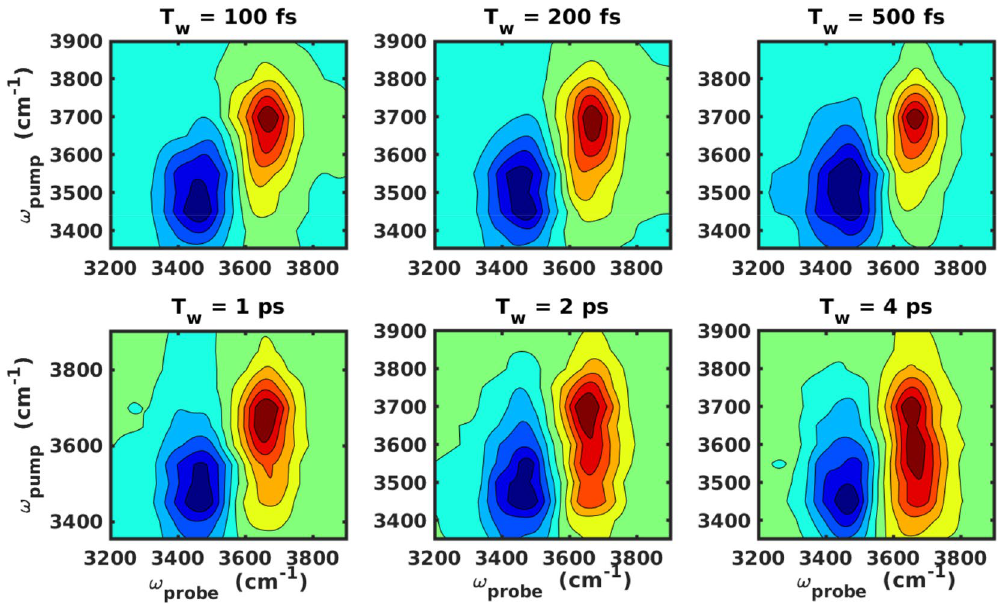
Figure 3. 2D-vSFG spectra of the interfacial water molecules as a function of T w waiting